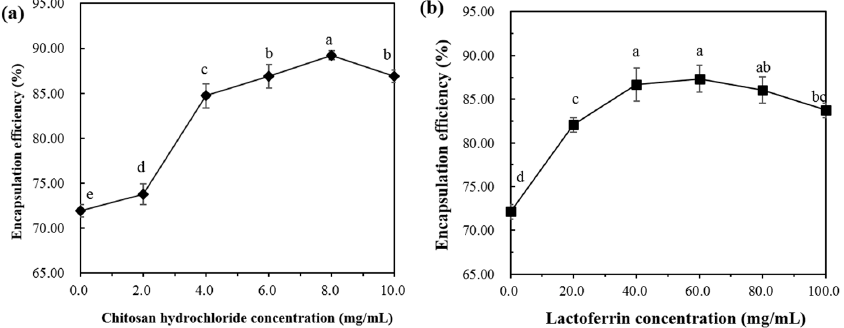
Figure 3. Encapsulation efficiency of liposomes at different concentrations of CH ( a ) and LF ( b ). Different lowercase letters indicate significant differences between groups ( p <